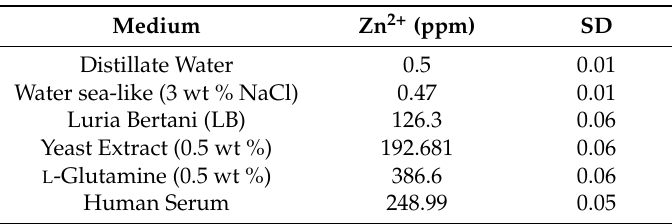
Table 1. Zn 2+ released from the ZnO35 powder to the media after 24